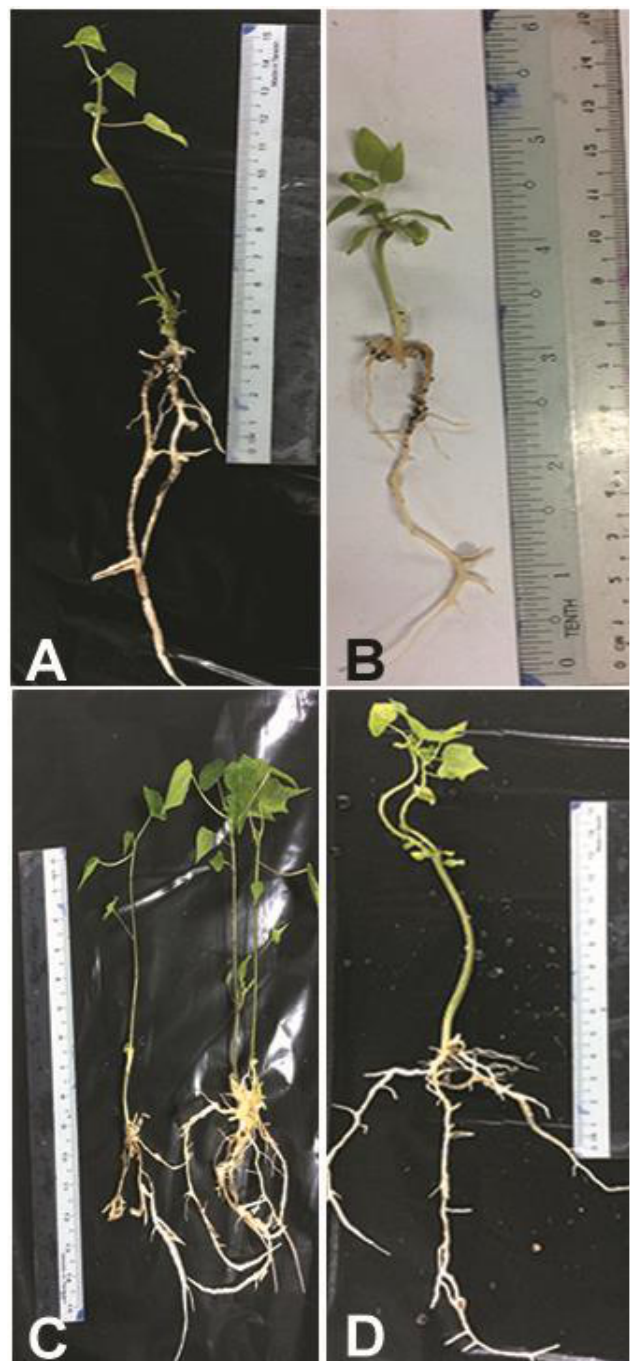
Figure 10. C. papaya “Eksotika” ( A ) explants rooted in R1 medium, ( B ) explants rooted in R2 medium, ( C ) explants rooted in R3 medium, ( D ) explants rooted in R4 medium.